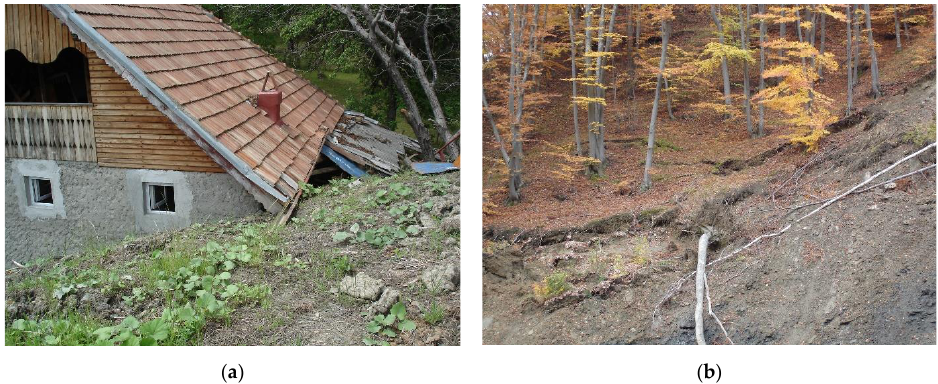
Figure 16. The impacts of the Chirlesti mudflow ( a ) in an urban area where soil covered the building up to the roof; ( b ) forested area along the streambank that collapsed.